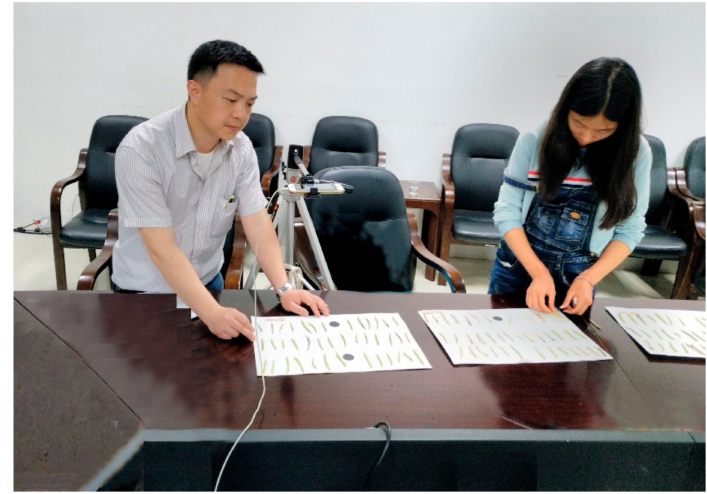
Figure 3. The image acquisition scheme.